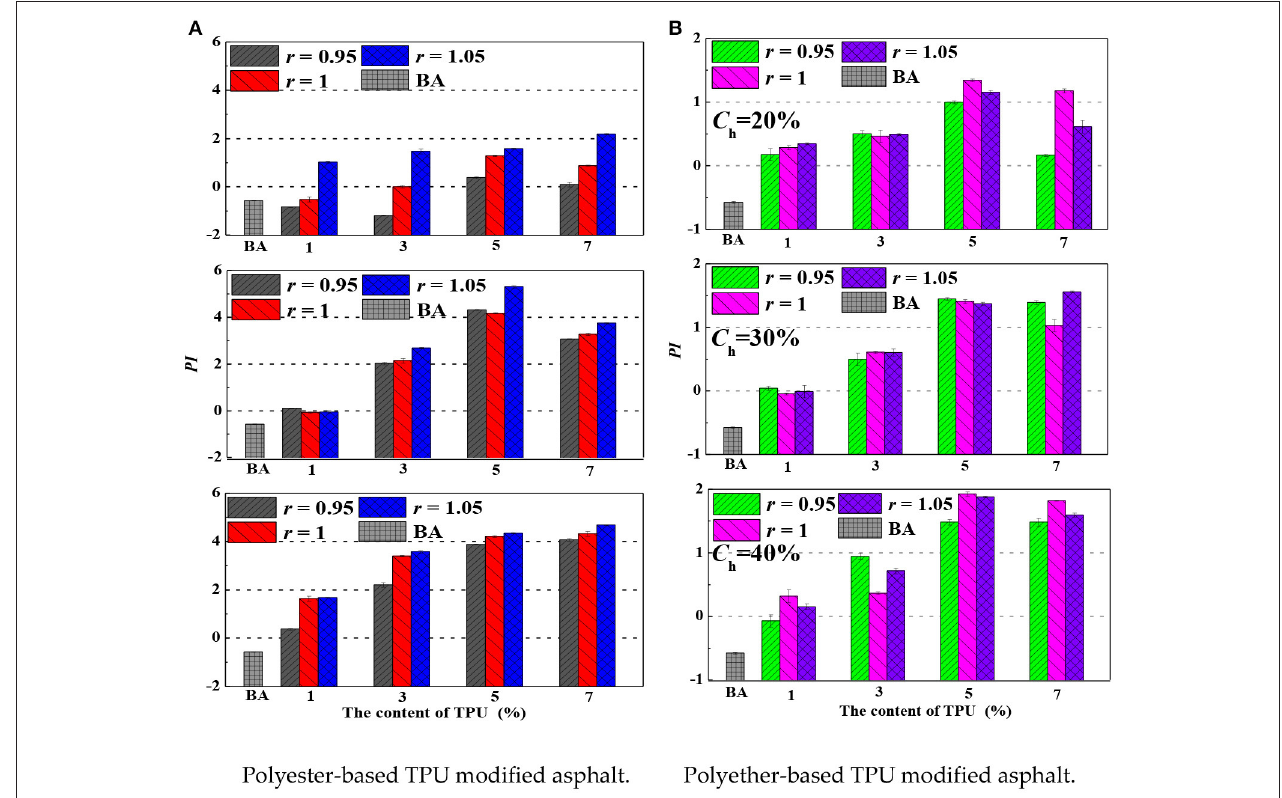
FIGURE 11 | The penetration index ( PI ). (A) Polyester-based TPU-modified asphalt. (B) Polyether-based TPU-modified asphalt.